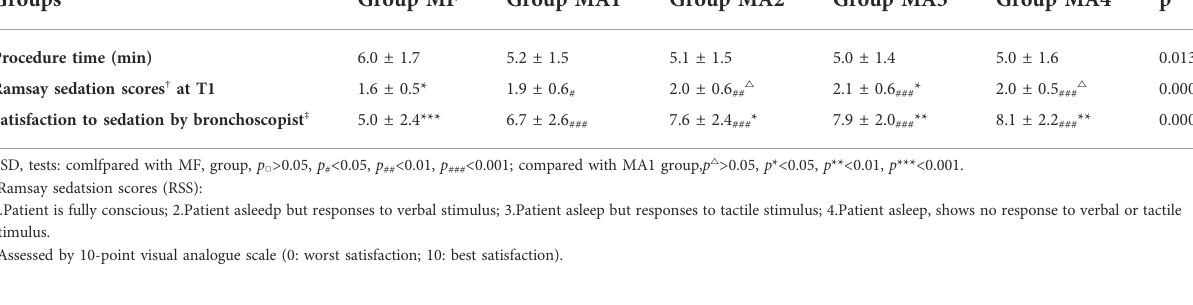
TABLE 6 Comparison of the fi ve groups with regard to indicators related to sedation (n = 50).